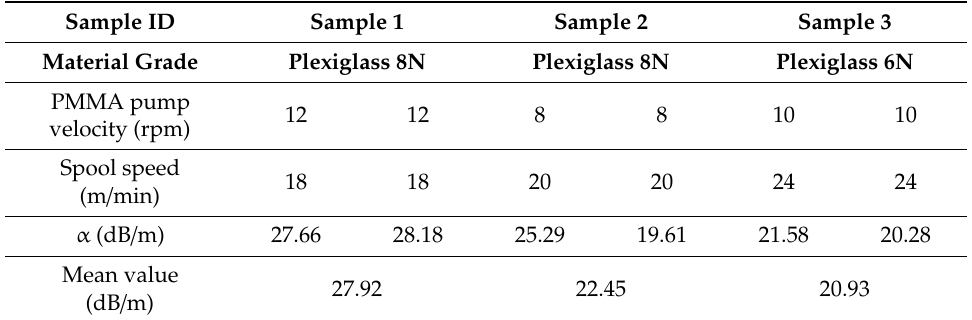
Table 2. Optical fiber losses ( α ) for plastic optical fibers (POFs) fabricated with different extrusion parameters.